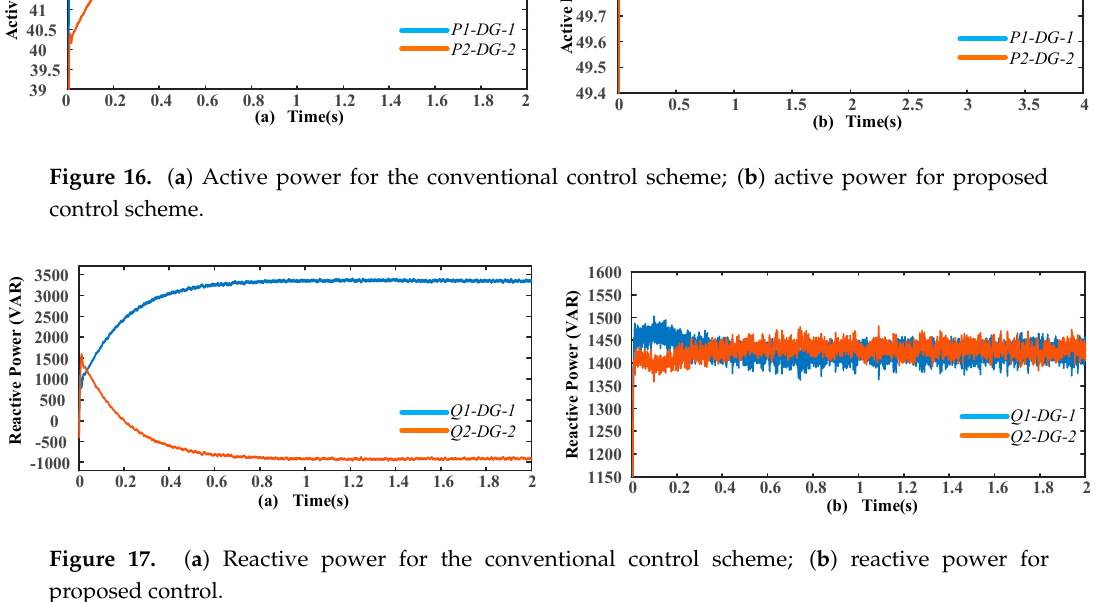
Figure 17. ( a ) Reactive power for the conventional control scheme; ( b ) reactive power for proposed control.